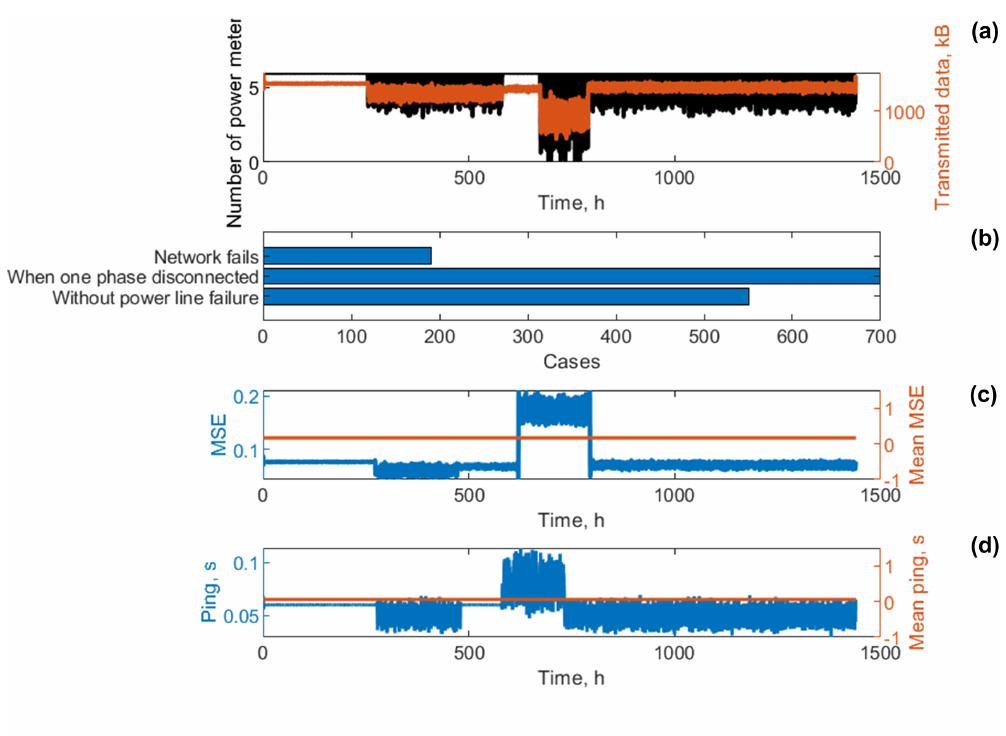
Figure 12. The analysis of network integrity by ( a )—number of power meters related to their data transmission and ( b )—number of failures, ( c )—Mean square error rate of failures and ( d )—data packets delay time through the experiment